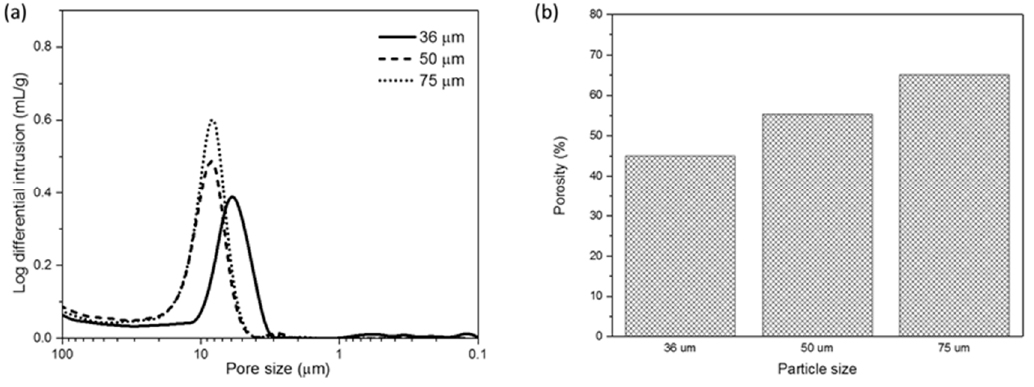
Figure 9. ( a ) The pore size distribution of the HFCM fabricated from different natural zeolite particle size and ( b ) porosity of the HFCM fabricated from different natural zeolite particle size.